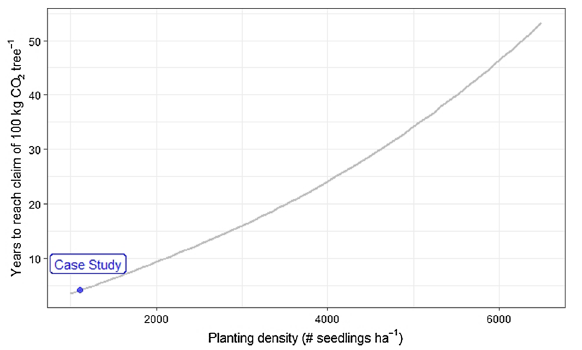
Figure 8. Effect of the planting density on the plot-scale carbon capture rate. No manual thinning and 100% seedling transplant survival are assumed. The blue dot represents the planting density of 1111 seedling ha −1 (where our model reach 100 kg CO 2 captured per tree 4.1 years after